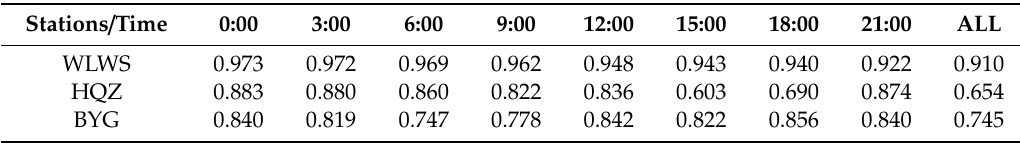
Table 5. The correlation coe ffi cients between the measured snow surface temperature and simulated values at di ff erent time